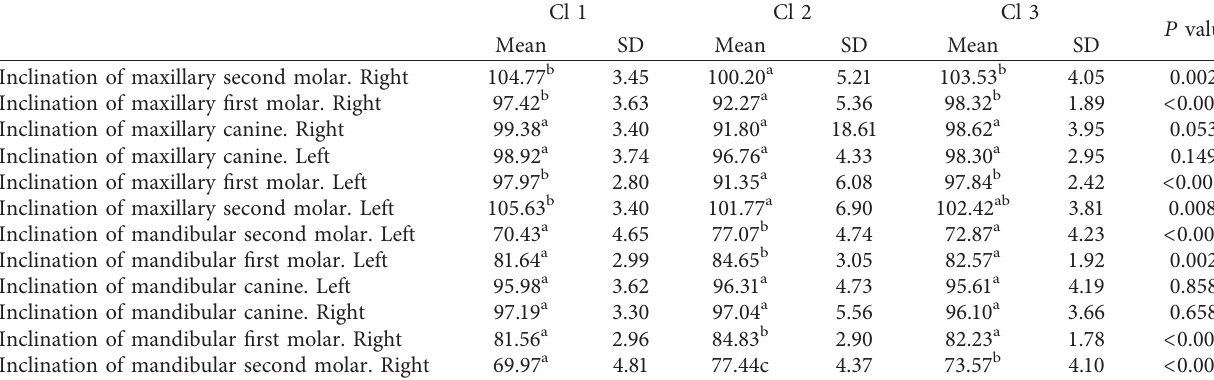
Table 2: Comparison of the inclination of teeth among the three sagittal skeletal patterns.